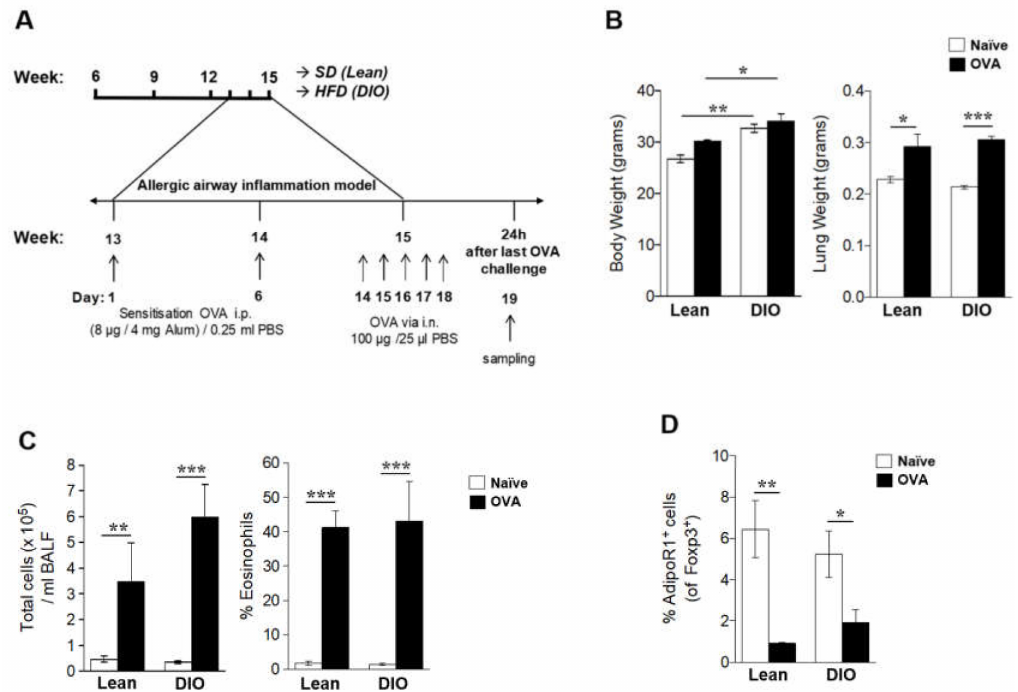
Figure 3. The AdipoR1 expression in lung Foxp3 + Tregs was diminished in lungs of DIO naïve and allergic mice. ( A ) The experimental design for the induction of allergic lung inflammation in DIO mice fed with a high-fat diet (HFD) or lean mice fed with a standard diet (SD) up to 15 weeks of age (overweight vs. lean, respectively). Naïve mice were used as controls for the allergic lung inflammation model. ( B ) Terminal body and lung weight at 15 weeks of age. ( C ) Total number of inflammatory cells and eosinophils in bronchoalveolar lavage fluid (BALF). ( D ) Frequency of AdipoR1 in lung Foxp3 + Tregs. The AdipoR1 + population was gated within CD3 + CD4 + Foxp3 + cells. Data are means ± SEM of n = 3–6 mice per group. Unpaired t test * p < 0.05, ** p < 0.01, and *** p < 0.001. DIO, diet-induced obesity; AdipoR1, adiponectin receptor 1; Tregs, regulatory T cells; and OVA,